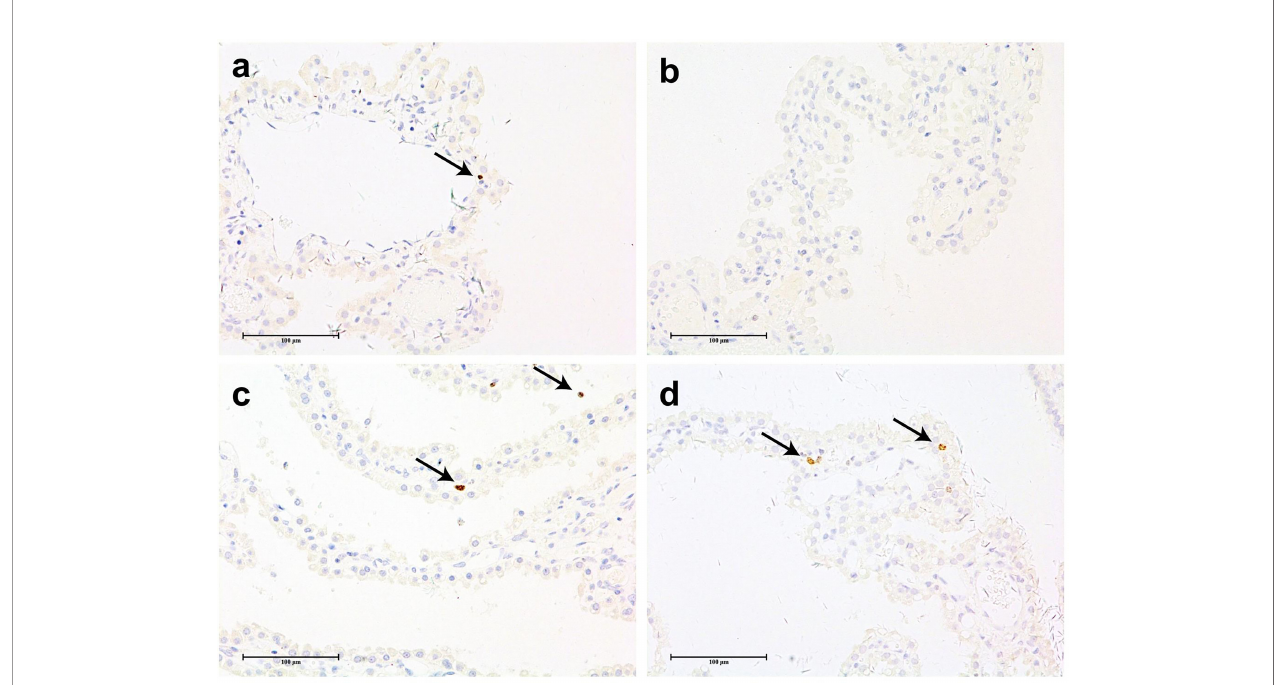
FIGURE 6 | Anti-ki67 IHC staining of cynomolgus monkeys CP epithelium with 52-week administration of Jintrolong. (A) Anti-ki67 staining of excipient control group. (B) Anti-ki67 staining of 0.3 mg/kg/week Jintrolong group. (C) Anti-ki67 staining of 1 mg/kg/week Jintrolong group. (D) Anti-ki67 staining of 3 mg/kg/week Jintrolong group. Arrows in panels (A, C, D) showed representative cells with positive anti-Ki-67 staining. The scale bar is 100